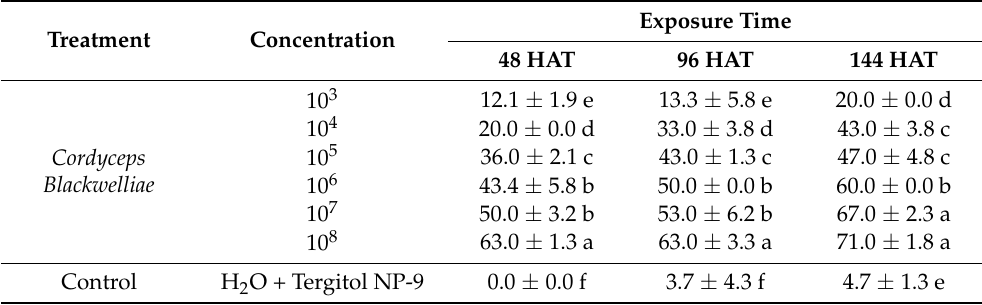
Table 3. Mean mortality ( ± SD) of T. pityocampa larvae. There is no significant difference between the mean of the same column followed by the same letter (Tukey’s test, a = 0.05), HAT: Hours After